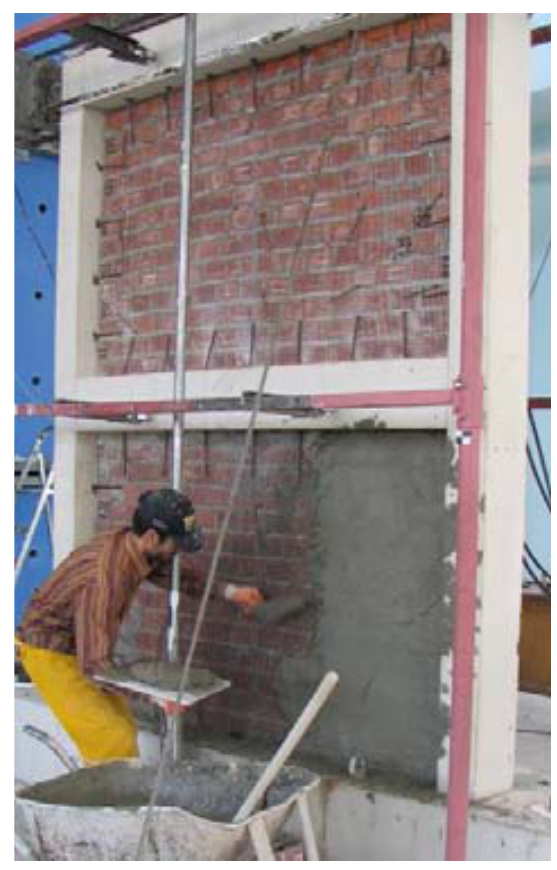
Figure 11 Preparation of specimen SPS2 Fig. 11. Preparation of specimen